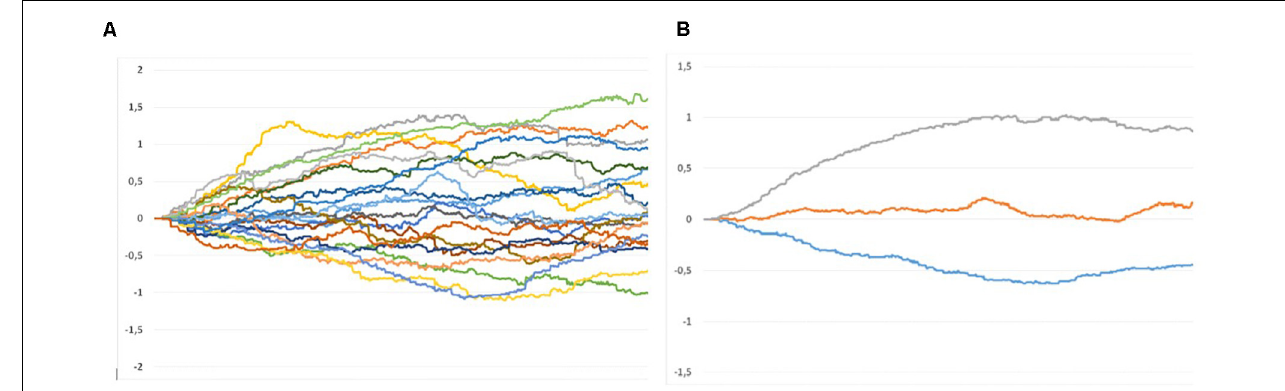
FIGURE 4 | Continuous RTR rapport ratings. (A) Averaged for each of the 20 stimulus clips across 88 observers. (B) Averaged for 7 high, 6 neutral, and 7 low rapport